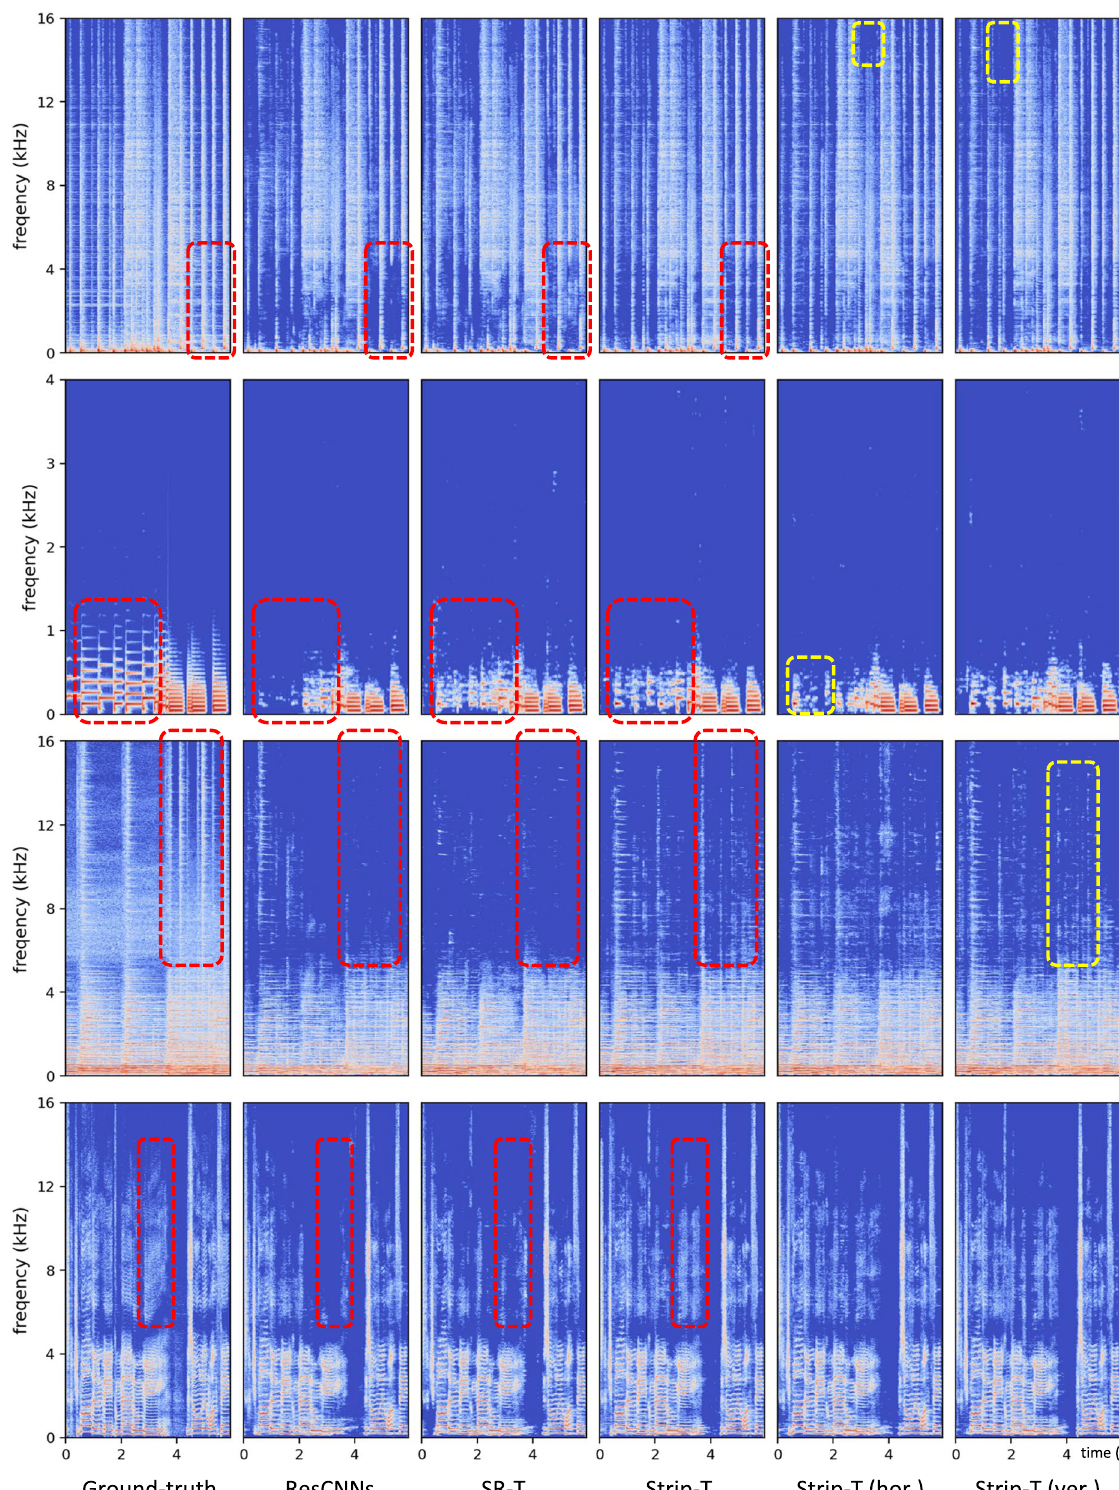
Fig. 7 Comparison of reconstructed magnitudes using different backbone networks. The four rows from top to bottom are drums, bass, other, and vocals target source, which is taken from a roughly 6-s piece of Schoolboy